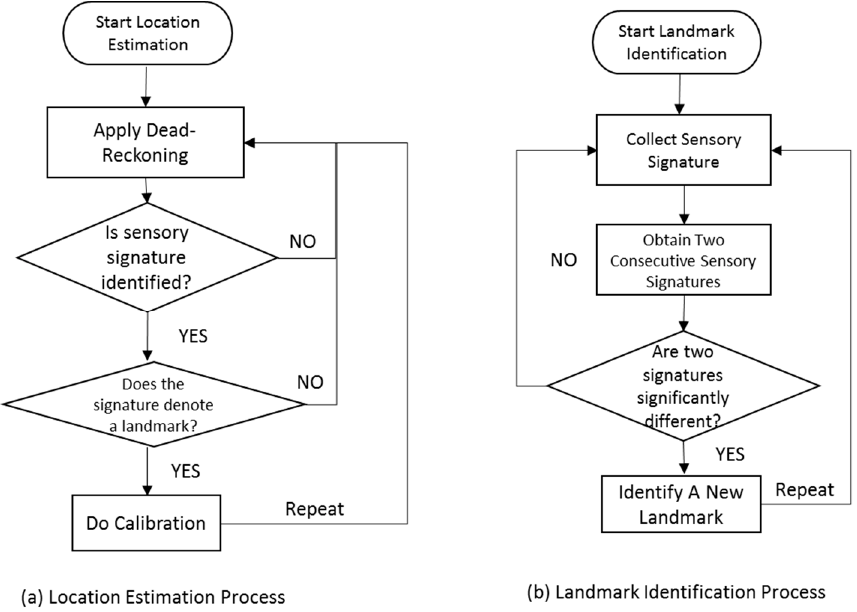
Figure 4. Process of landmark identification and location estimation.